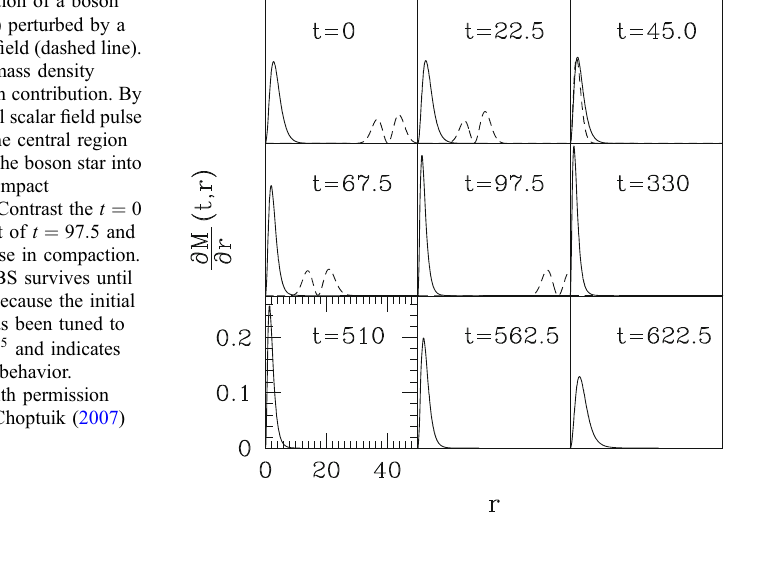
Fig. 34 Evolution of a boson star (solid line) perturbed by a shell of scalar fi eld (dashed line). Shown is the mass density o M = o r for each contribution. By t (cid:5) 100 the real scalar fi eld pulse has departed the central region and perturbed the boson star into an unstable, compact con fi guration. Contrast the t ¼ 0 frame with that of t ¼ 97 : 5 and note the increase in